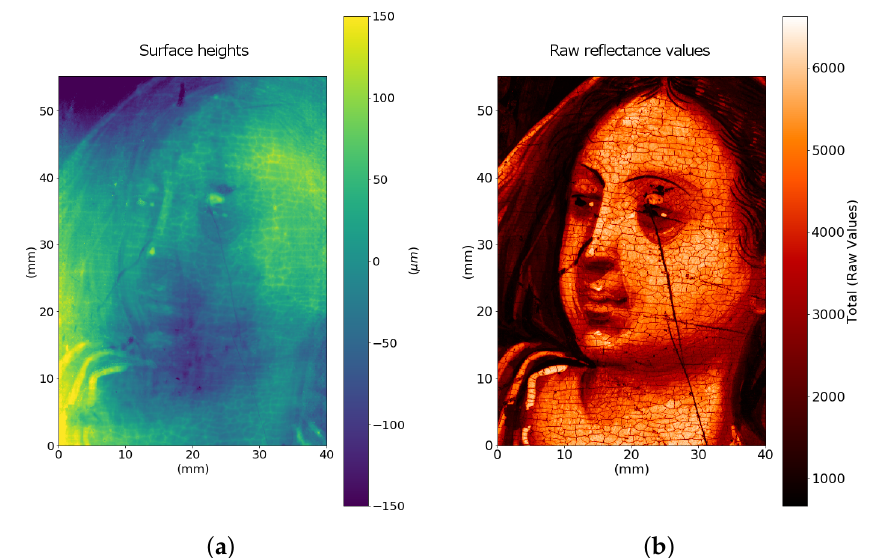
Figure 7. ( a ) Surface height dataset and ( b ) raw reflectance total dataset of an ROI of the painting acquired by the microprofilometer at a 50µm sampling step. The two maps are spatially registered at micrometric precision.